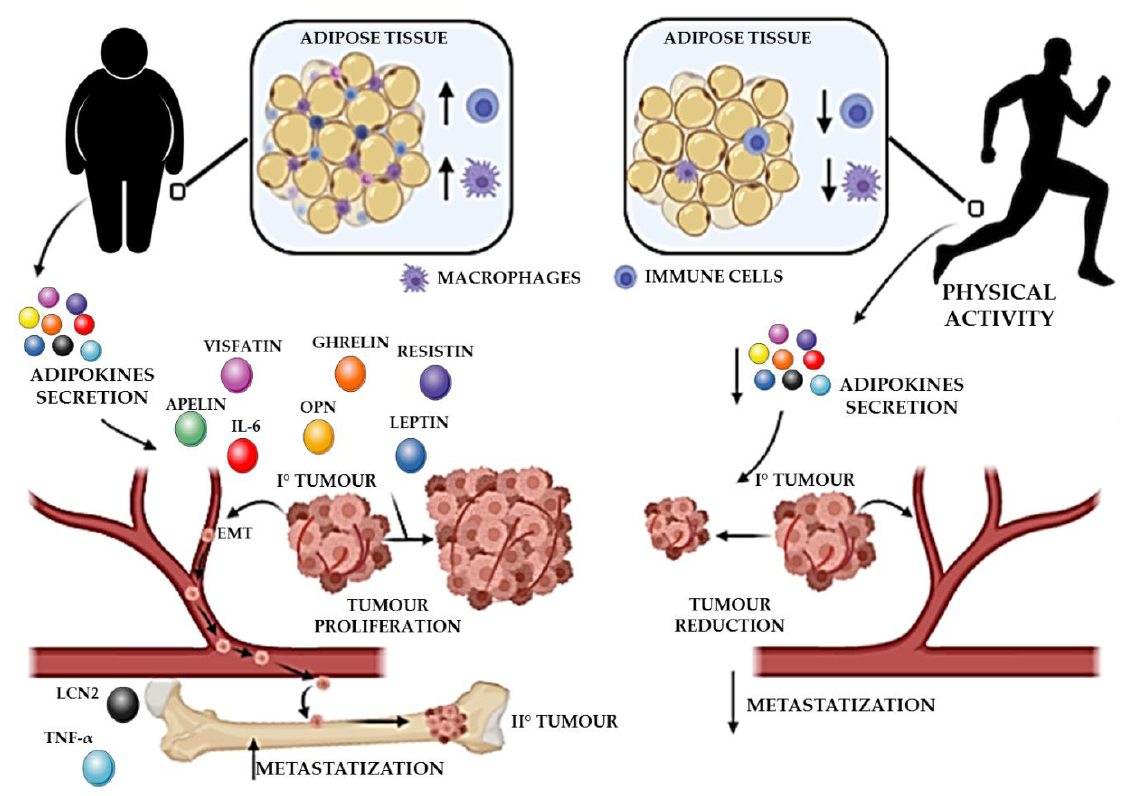
Figure 1. Roles of adipokines in tumor progression—sedentary lifestyle vs. physical activity.